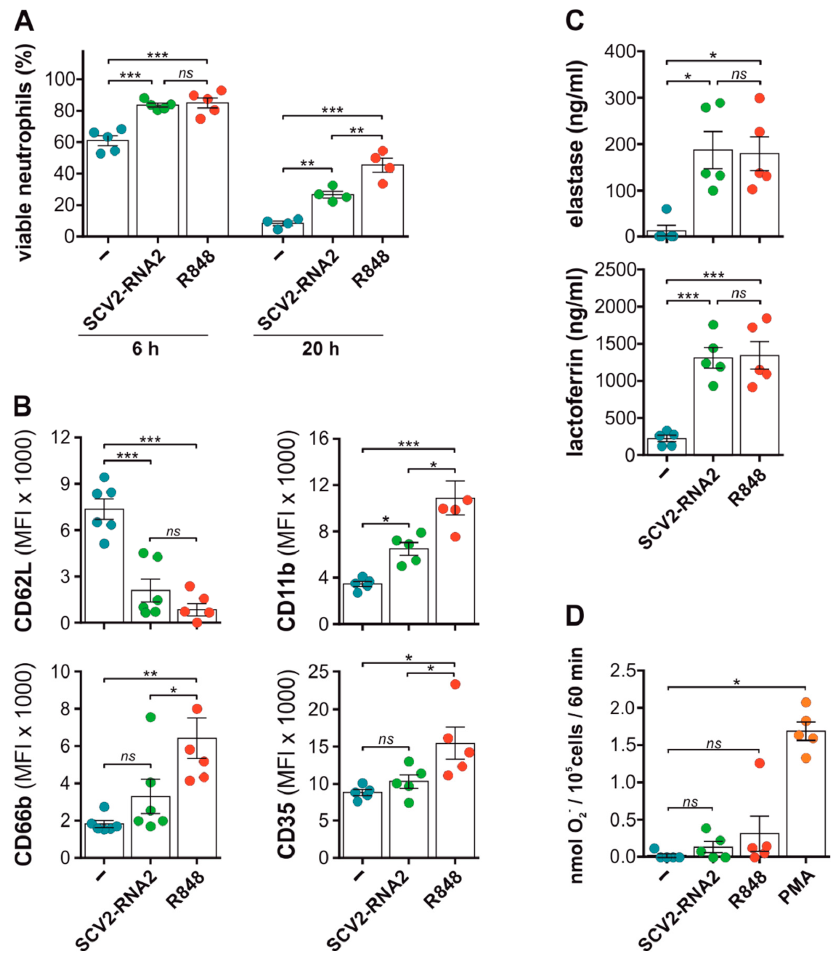
Figure 2. SCV2-RNA2 efficiently activates neutrophil effector functions. ( A , B ) Neutrophils were incubated for six ( A , B ) or 20 h ( A ) with or without 10 μ g/mL SCV2-RNA2 or 5 μ M R848. Cells were then collected, and neutrophil viability ( A ) and surface marker expression ( B ) were evaluated by flow cytometry. ( A ) Histograms show the percentage of viable cells (mean ± SEM, n = 4–5) defined as Vybrant™/Sytox™ double negative cell population (see Section 2). ( B ). After stimulation, neutrophils were incubated with specific fluorochrome-conjugated antibodies anti-CD66b, -CD11b, -CD62L, and -CD35 to evaluate their membrane expression by flow cytometry. Histograms show the median of the mean fluorescence intensity (MFI) ± SEM, obtained from n = 5–6 independent experiments. ( C ) Release of granule protein in stimulated neutrophils. Neutrophils were incubated for three hours with or without 5 μ M R848 and 10 μ g/mL SCV2-RNA2 and supernatants were collected. The release of elastase (upper panel) and lactoferrin (lower panel) was assessed by ELISA assays. Results are expressed as mean value ±SEM from n = 4–5 independent experiments. ( A – C ) * p < 0.05, ** p < 0.01, *** p < 0.001, analysis was performed using one-way ANOVA corrected for Holm–Sidak’s multiple comparison test. ( D ) Superoxide anion (O 2 − ) production in SCV2-RNA2 stimulated neutrophils. Isolated neutrophils were left untreated or stimulated with 10 μ g/mL SCV2-RNA2, 5 μ M R848 and 20 ng/mL PMA. Histograms show the amount of nmol of O 2 − produced by neutrophils after 60 min of stimulation, measured by cytochrome C reduction assay (see Section 2). Results are expressed as the mean value ±SEM of n = 5 independent experiments. ns ( not significant) p > 0.05, * p < 0.05, ** p < 0.01, *** p < 0.001, by Kruskal–Wallis and Dunn’s post hoc test. ( A – D ) Results for every experiment are indicated by colored dots.